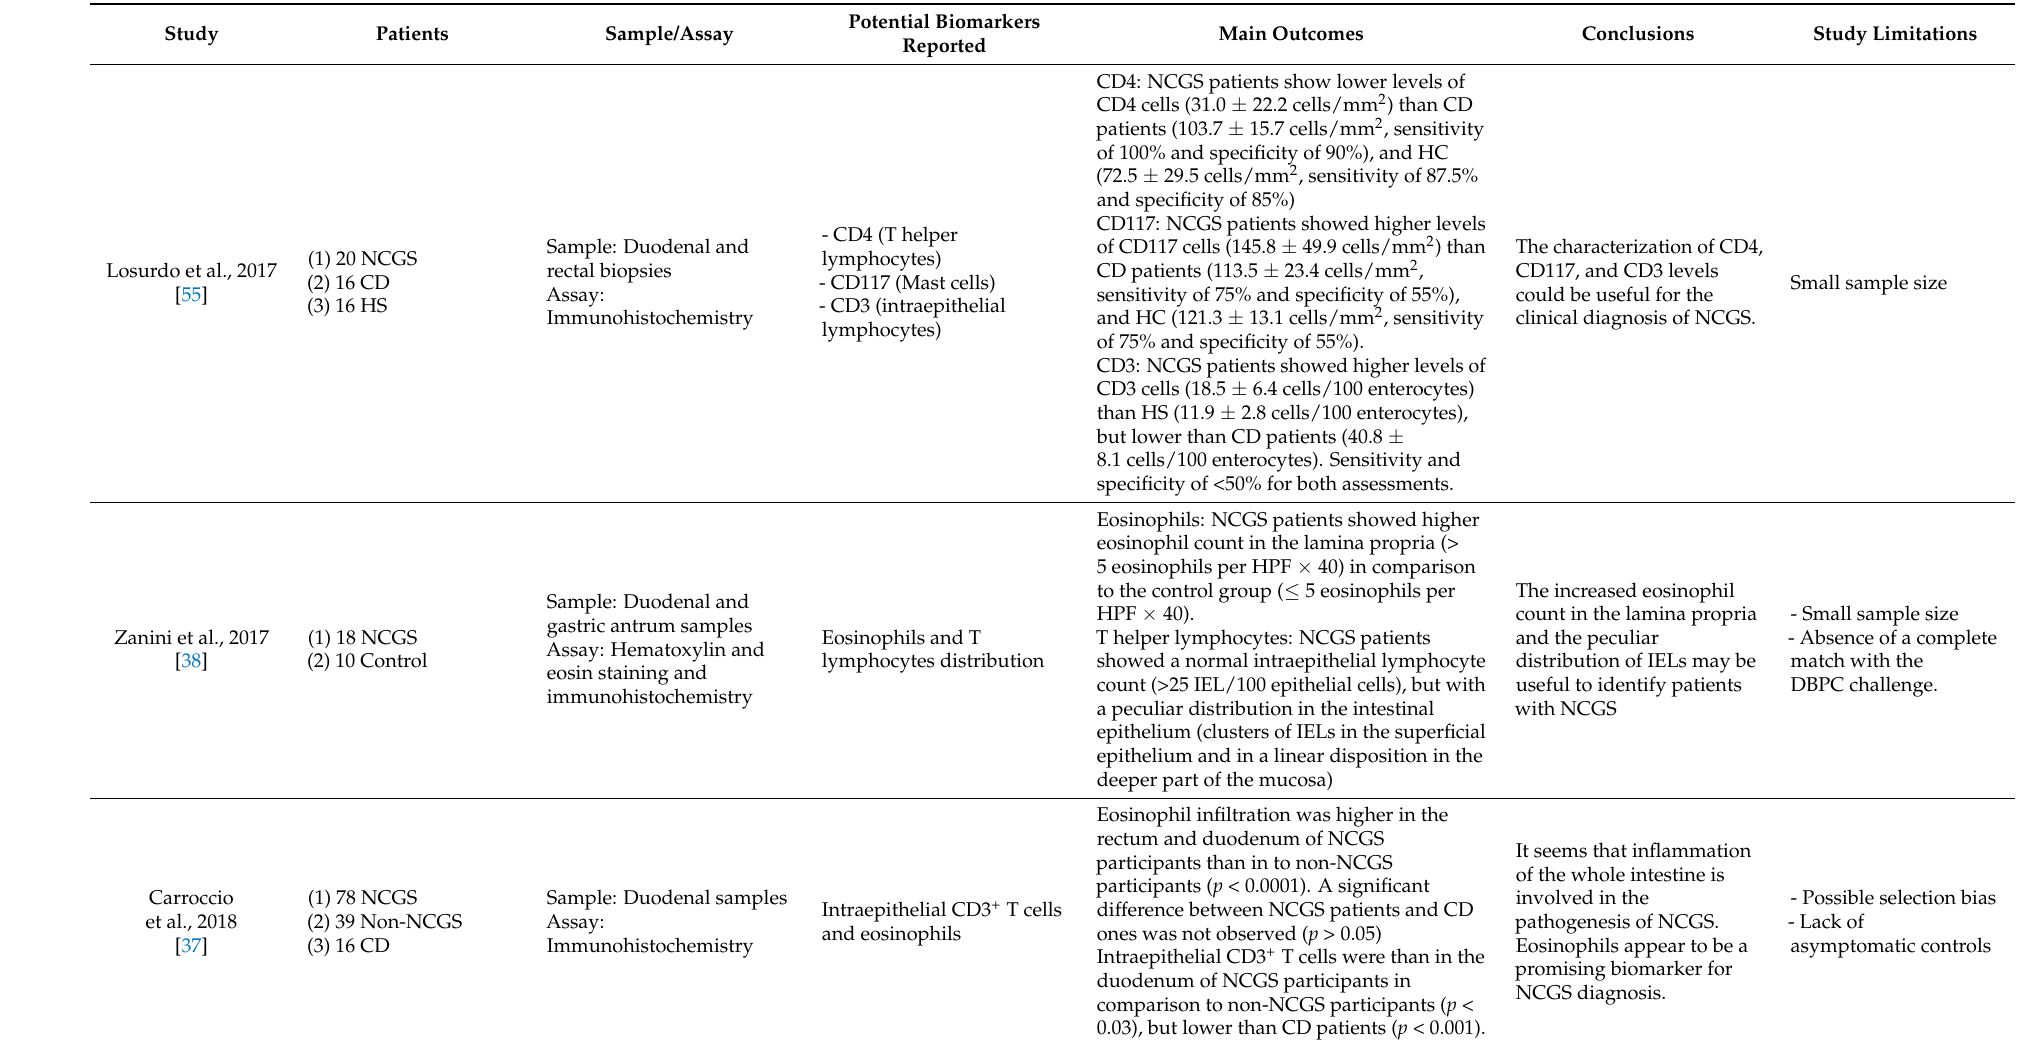
Table 2. Potential biomarkers for the diagnosis of